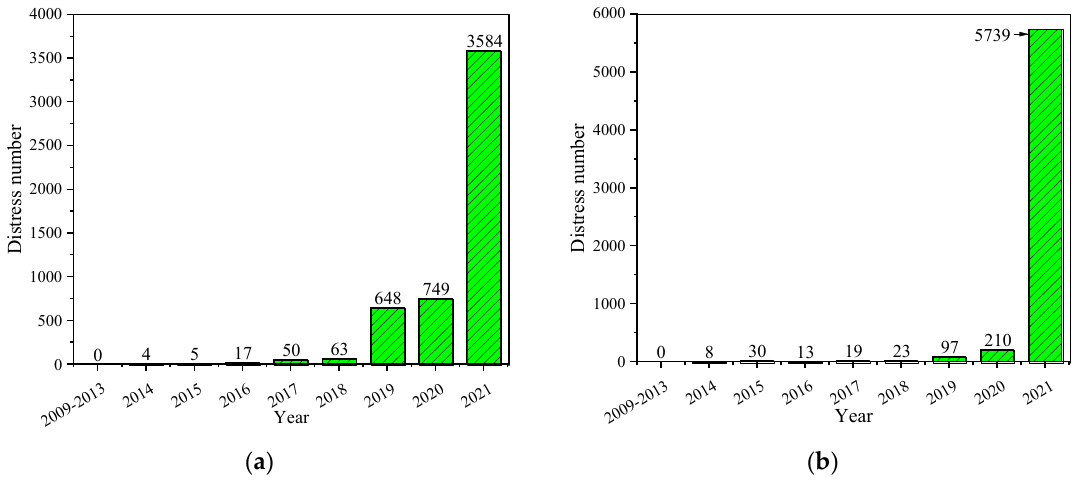
Figure 15. Variation of XHMB and JTB pavement distresses number: ( a ) Xihoumen Bridge (XHMB); ( b ) Jintang Bridge (JTB).